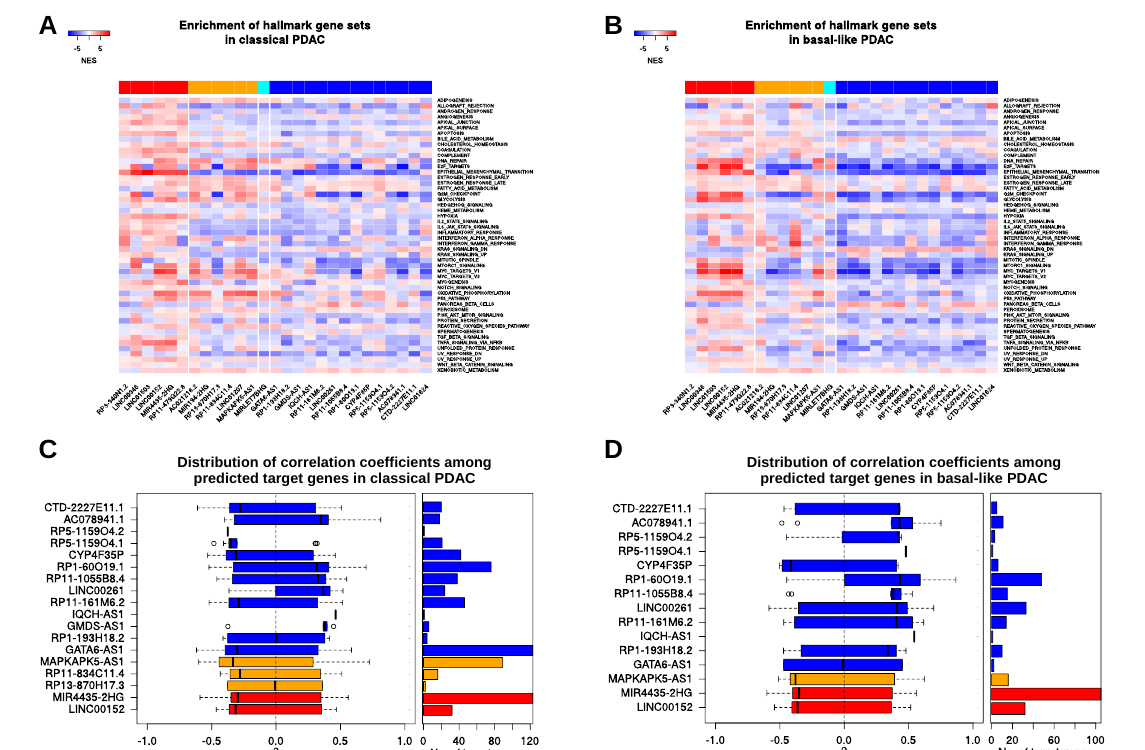
Figure 5. Guilty-by-association studies and potential mRNA-lincRNA-interactions. ( A , B ) Normalized enrichment scores (NES) obtained from gene set enrichment analyses (GSEA) using sorted Spearman correlation coefficients ( ρ ) of protein-coding genes related to the respective 27 lincRNA in classical ( A ) and basal-like ( B ) PDAC samples. Considered were the 50 MSigDB hallmark gene sets. Column color codes denote lincRNAs upregulated in both tumour subtypes compared to normal pancreas with significantly higher expression in the basal-like subtype compared to the classical subtype (red); upregulated in both subtypes and significantly lower in the basal-like subtype (orange); downregulated in both subtypes and significantly higher expressed in the basal-like subtype (cyan); downregulated in both subtypes and significantly lower in the basal-like subtype (blue). ( C , D ) Number of